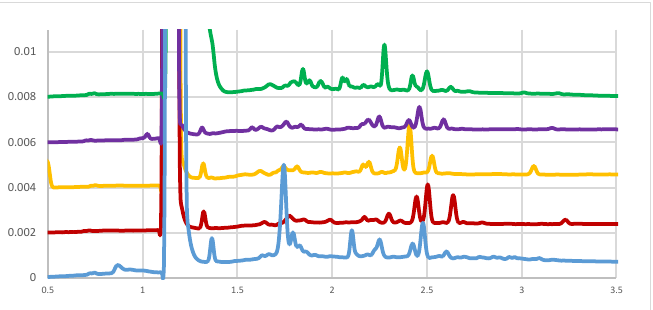
Figure 6. The comparison of electropherograms (PDA at 220 nm) obtained for blue denim fibres from five experimental fabrics. The results obtained for the fibres constituting the individual fabrics are presented in different colors.